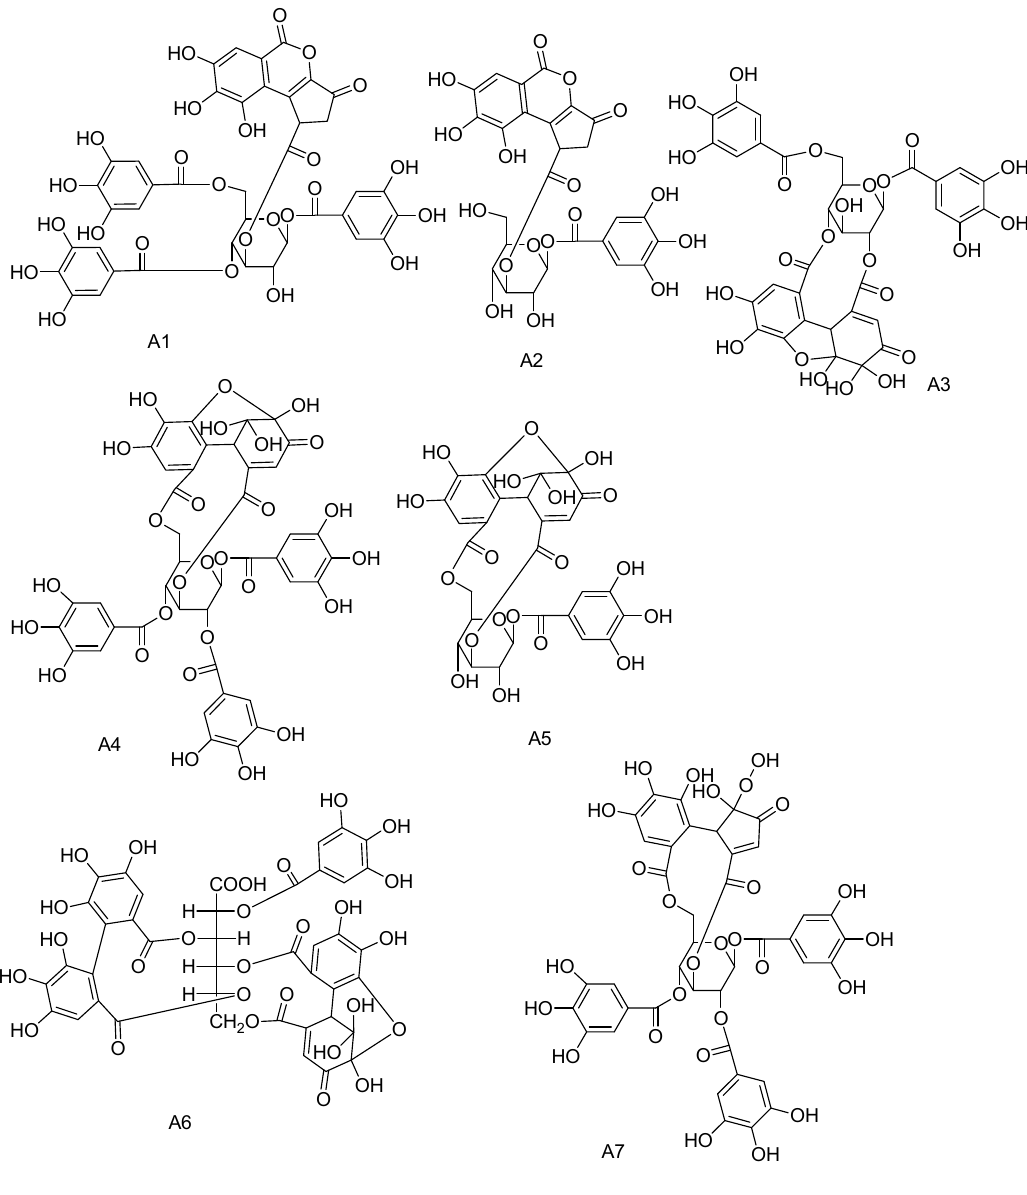
Figure 5. Structure of tannin type of A1 – A7 .